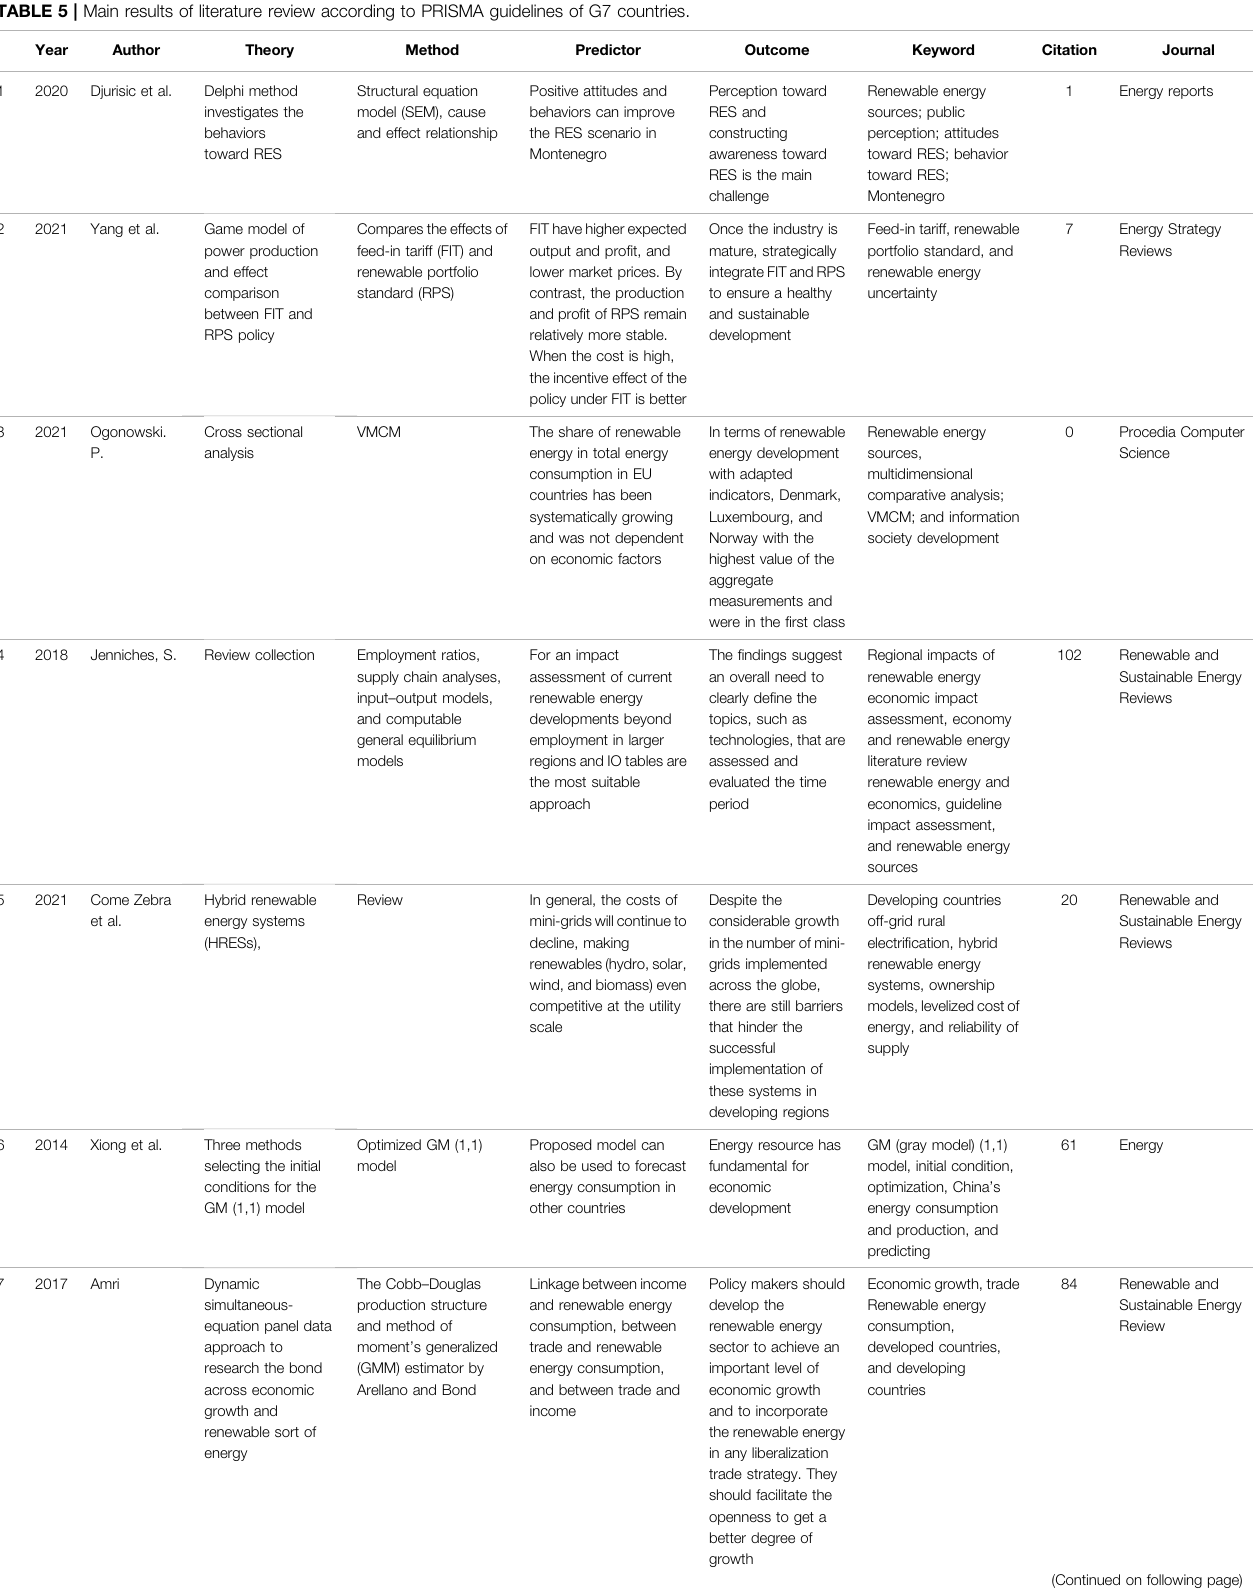
TABLE 5 | Main results of literature review according to PRISMA guidelines of G7